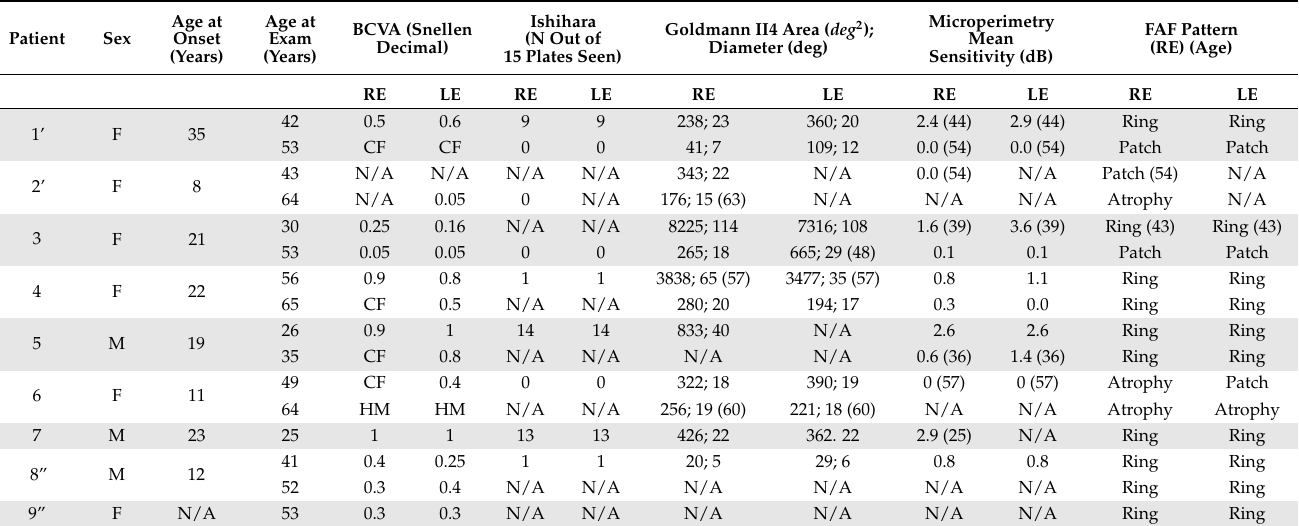
Table 2. Phenotypic characteristics of each patient at the first and last